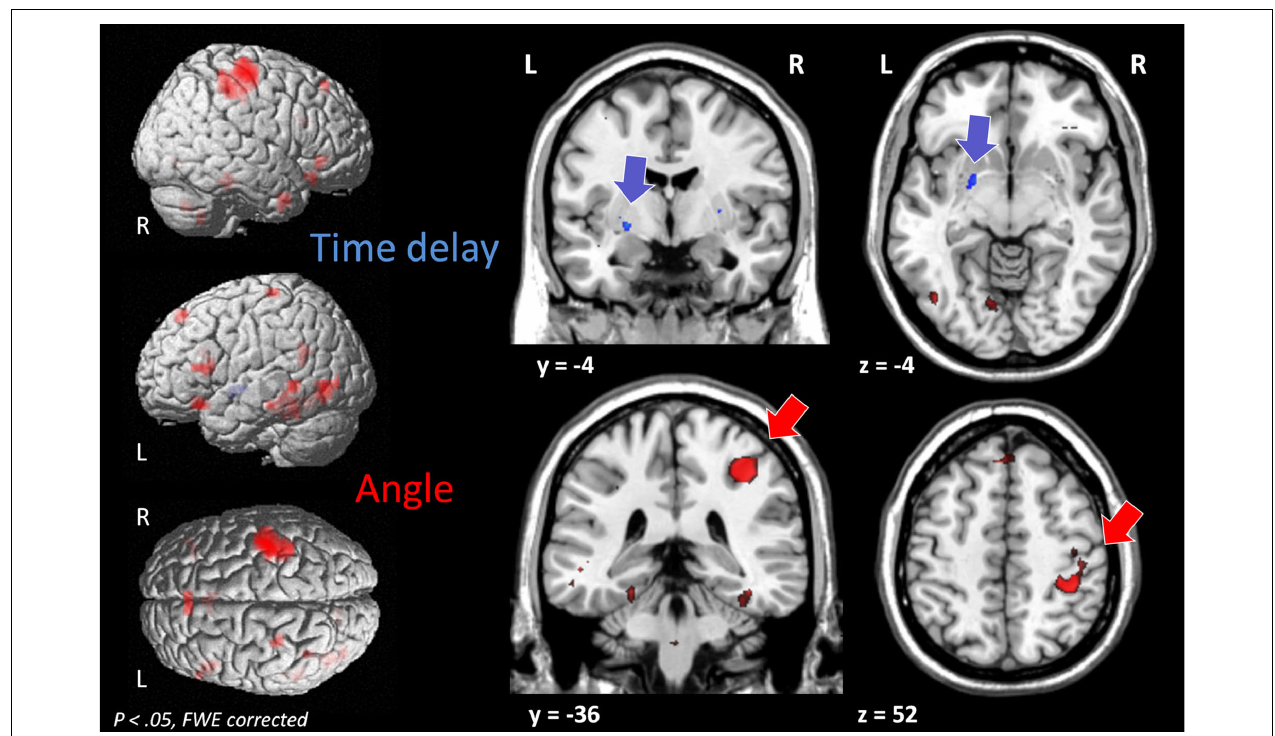
FIGURE 5 | The processing of spatial and temporal characteristics in relation to the judgments of causality. Shows the group activation map for the correlation of the processing of stimulus characteristics their individual predictive value for the